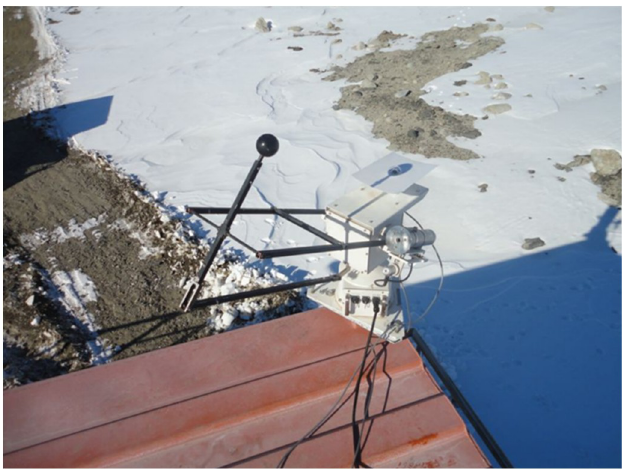
Figure 2. Photo of Solar-metric station of the instrument at Mario Zucchelli Station.